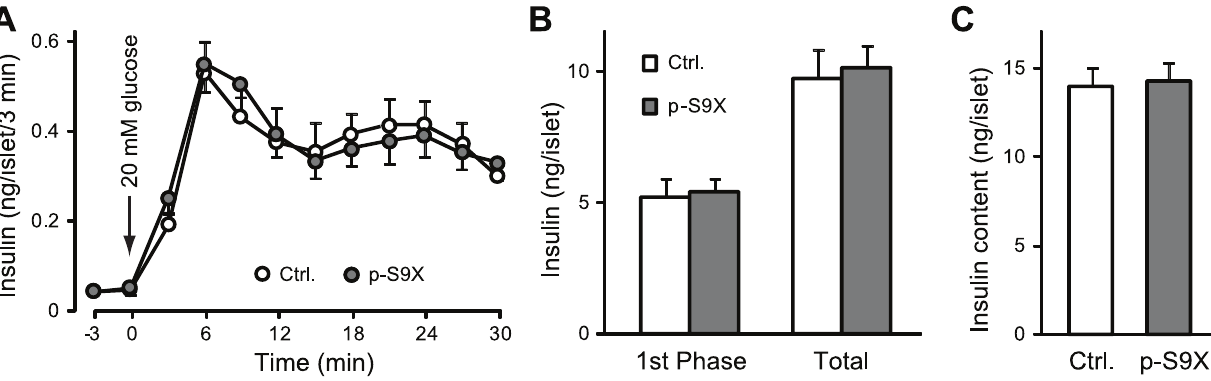
Figure 3. Glucose-stimulated insulin secretion from p-S9X mouse islets showed the same pattern as in control mouse islets. ( A ) Insulin secretion from batches of 5 similar-sized islets in perifusion experiments in response to 20 mM glucose (arrow). N=20 for control mouse islets (open circles), and 16 for p-S9X mouse islets (filled circles). ( B ) Insulin secretion during the first 15 minutes of stimulation (first phase) and over the entire stimulation period (total), calculated as sum of insulin levels in all fractions after baseline subtraction. (C) Insulin contents in isolated individual pancreatic islets from p-S9X and control mice. Data are presented as means 6 SEM. N=14 for control (white bar) and 19 for p-S9X (grey bar).